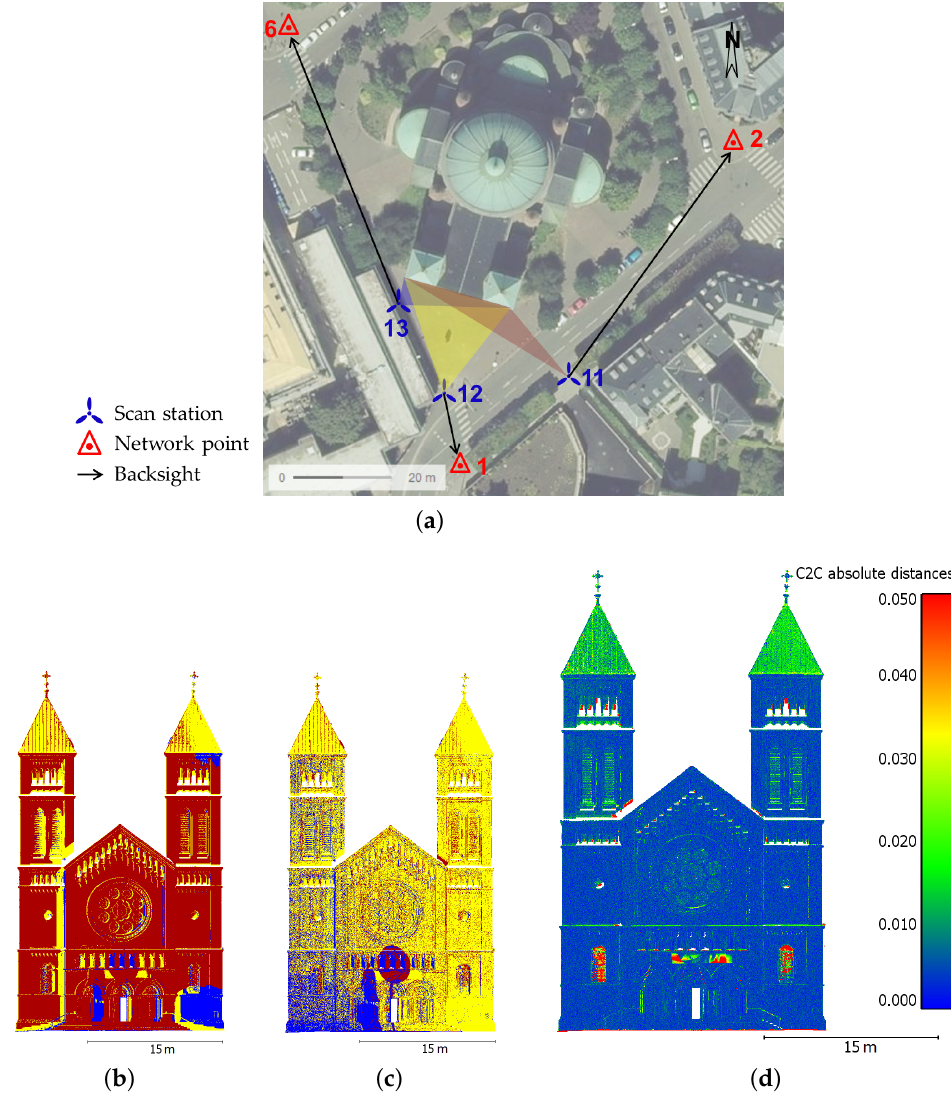
Figure 4. ( a ) Overview of the area around church facade; ( b ) Three point clouds acquired on the surveyed church facade without alignment refinement; ( c ) Point clouds finely registered after Iterative Closest Point (ICP); ( d ) Cloud-to-cloud comparison between FARO Focus 3D and Trimble SX10 point clouds of the facade. Deviations (unit: m) are projected on SX10 point